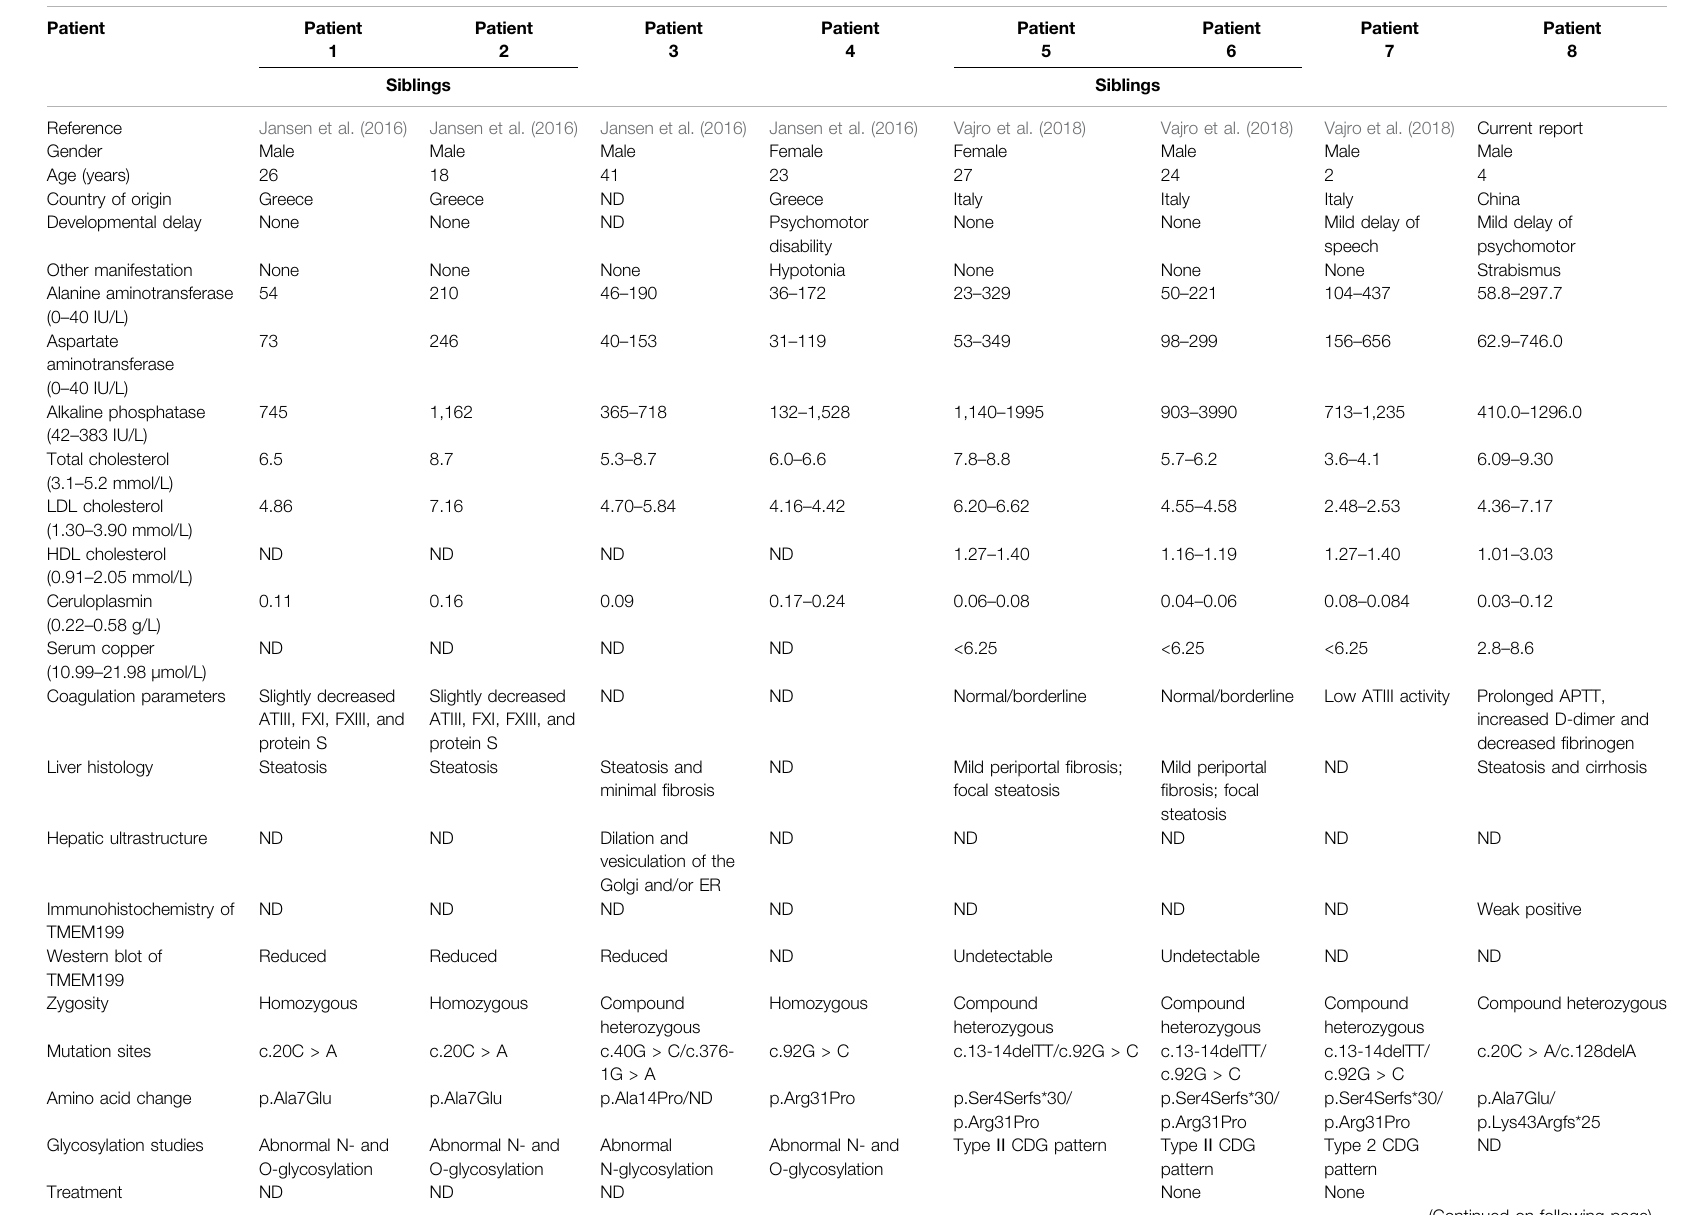
TABLE 2 | Main fi ndings of the eight patients with